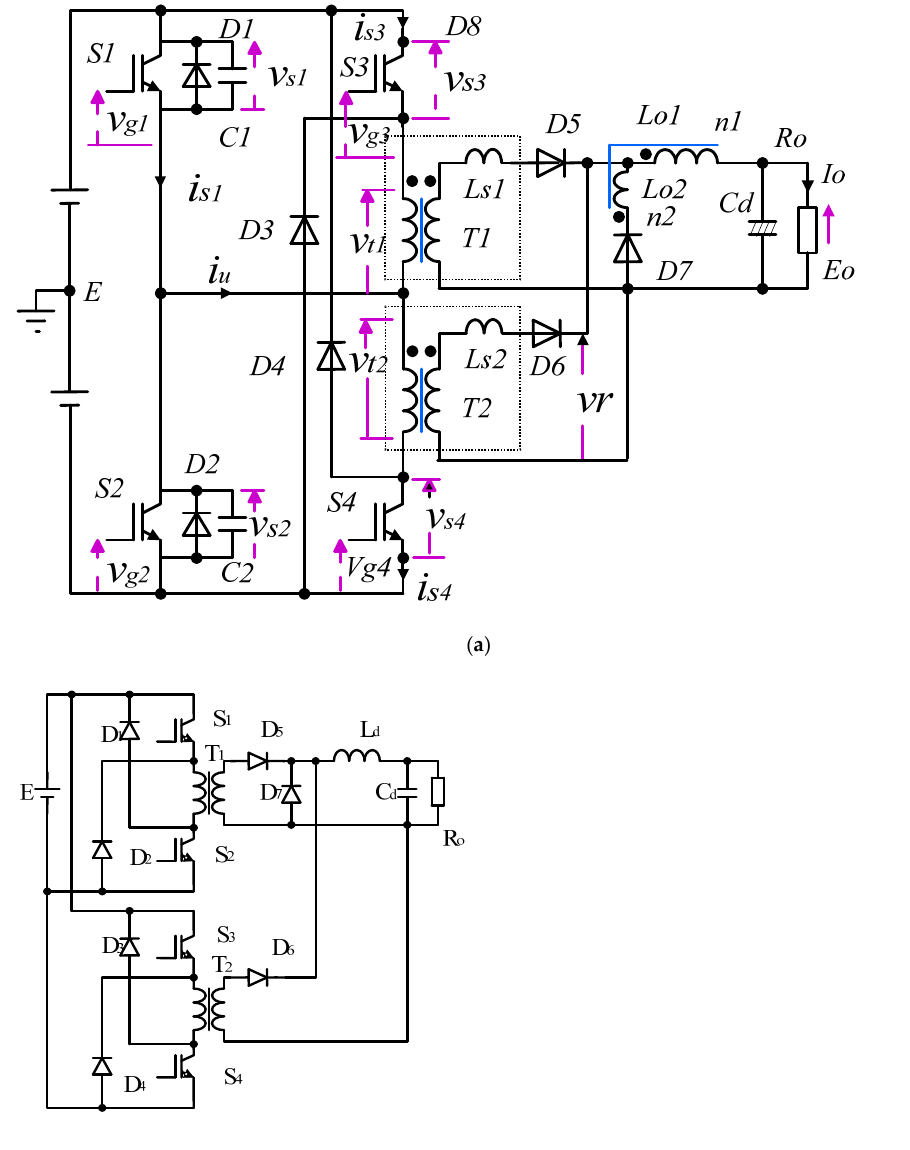
Figure 2. (a) Basic circuit configuration of the studied converter. ( b ) Two-switch interleaved hard-switched forward DC-DC converter.